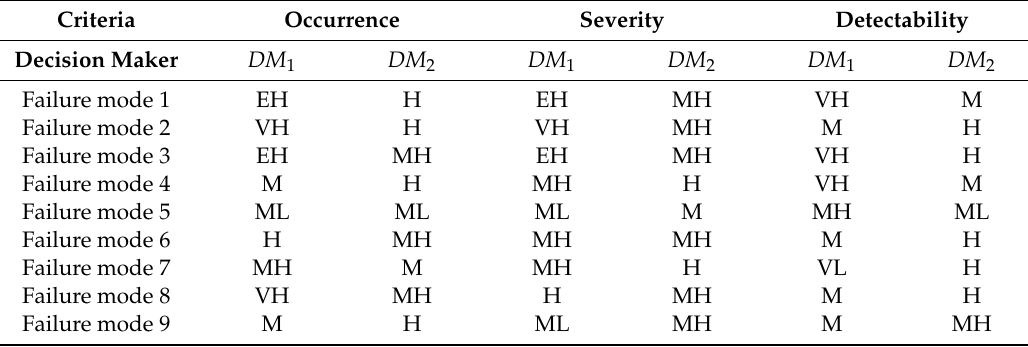
Table 6. Evaluation of the failure modes in each criterion by the DMs.